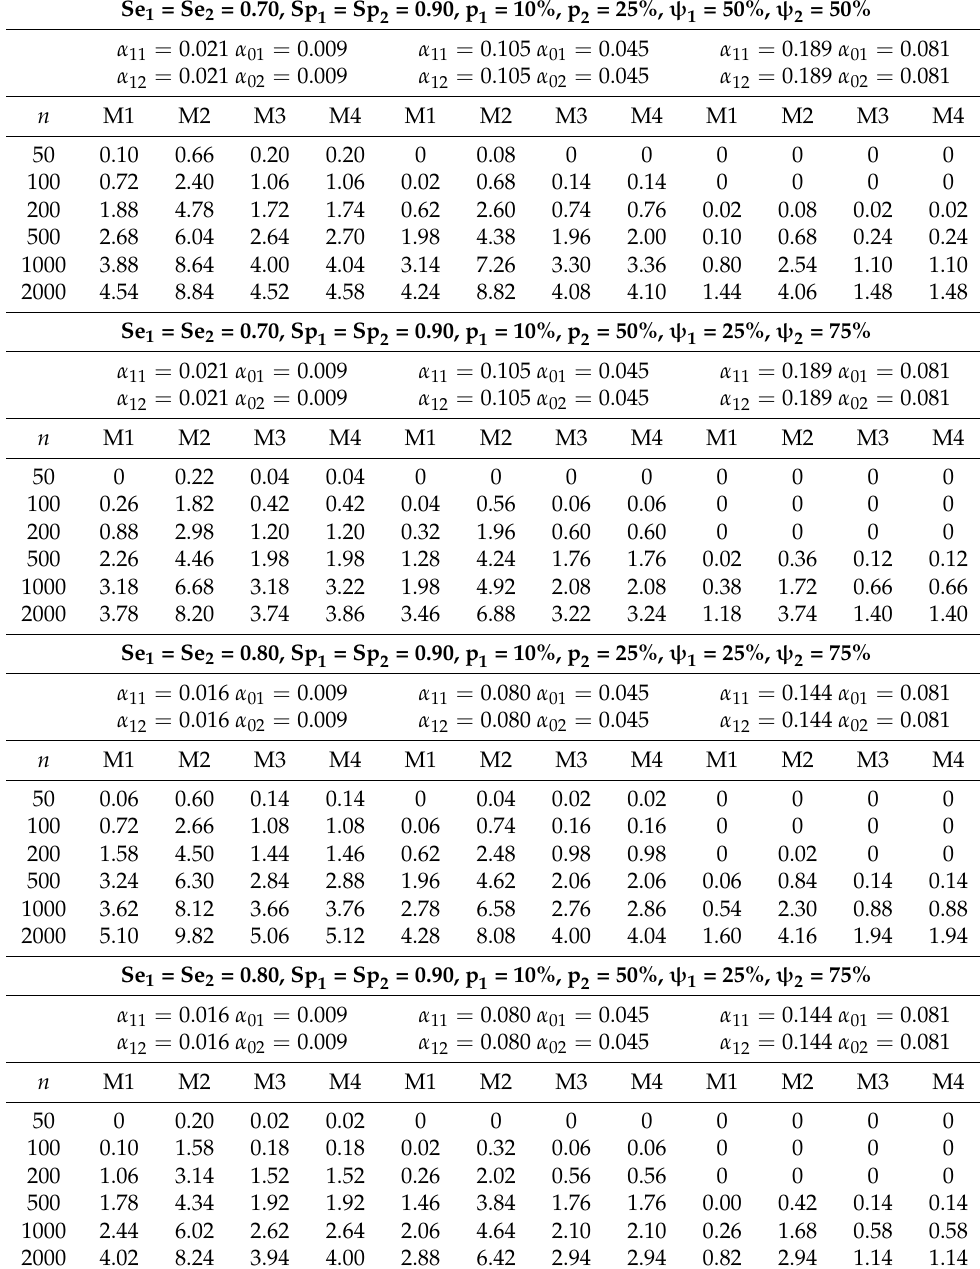
Table 3. Type I errors (in %) of different methods to simultaneously compare the sensitivities = { 0.70,0.80 } ) and specificities ( Sp ( Se h